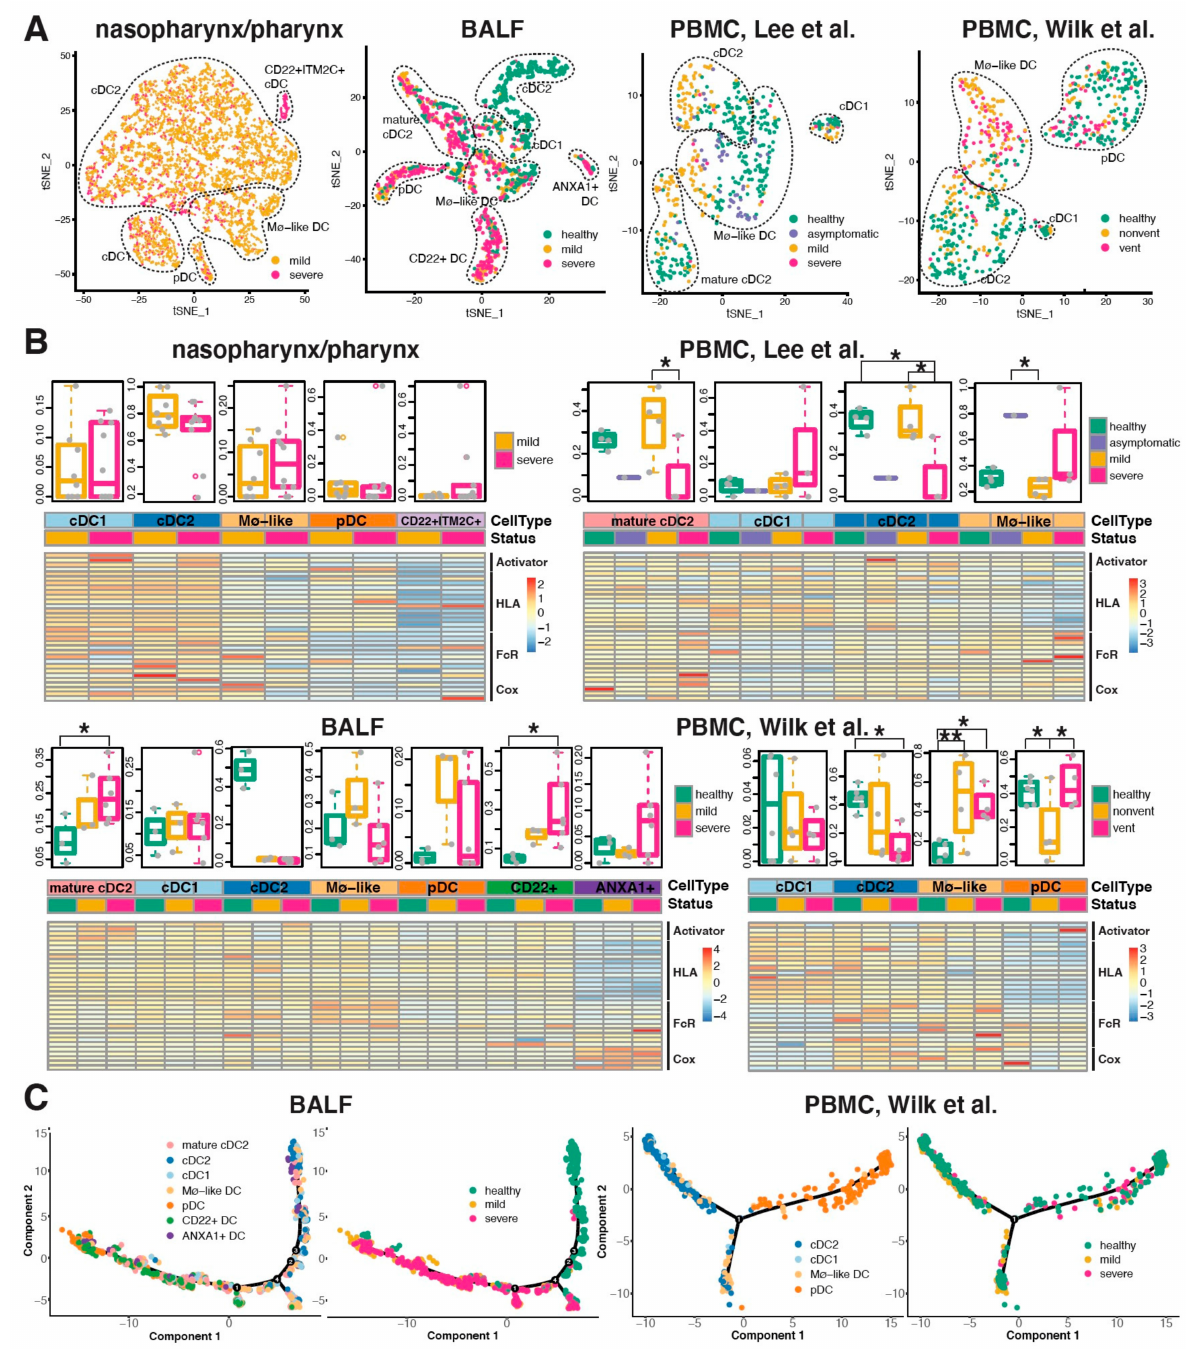
Figure 6. The variation of distributions and transcriptome profiles of DC subsets in COVID-19 samples and healthy controls at three sites. One upper airway (nasopharynx/pharynx), one lung (BALF) and two blood (PBMC) scRNA-seq datasets were analyzed. ( A ) shows DC subsets identified in single-cell transcriptome profiles from COVID-19 mild and severe cases and healthy controls. ( B ) shows the proportions (top) and expression of key players (bottom) of DC subsets in samples from each participant. The differences of proportion of each DC subset were tested in groups. Significance: * p < 0.05; ** p < 0.01. The average gene expression of the T-cell stimulation activators (CD83, CD40, CD80, CD86), MHCII and FcRs in subsets in samples with different disease status were shown in the bottom heatmap. Red indicates relative higher expression and blue indicates relative lower expression. The scale corresponds to the log 2 (normalized scRNA-seq read count) which was centered and scaled by row. ( C ) Single-cell trajectory of DCs inferred by Monocle from scRNA-seq data of BALF and PBMC samples. For each dataset, the left shows ordered cells labeled with cell types, while the right shows ordered cells from COVID-19 mild and severe cases, and healthy